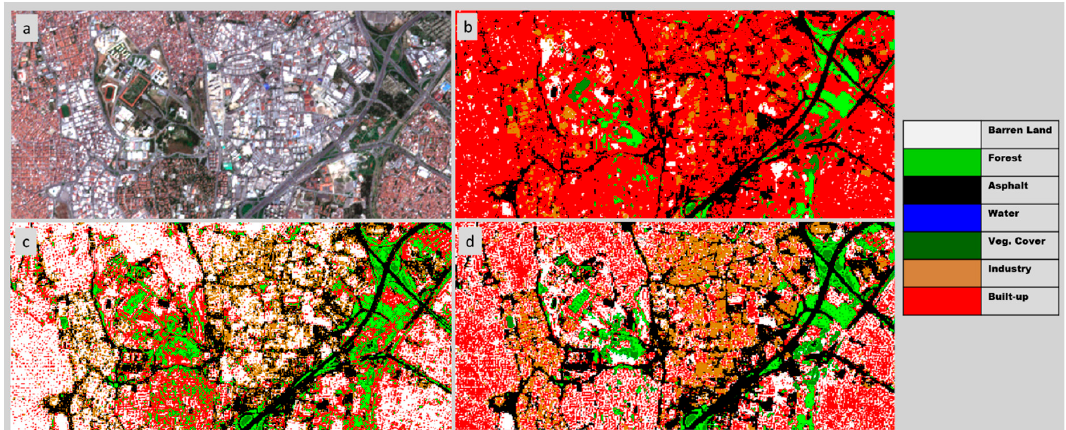
Figure 9. ( a ) RGB image of the Sentinel-2A; ( b ) the classified Sentinel-2A; ( c ) the classified multi-index (NDBI, NDVIre, and MNDWI), and ( d ) the classified multi-index (NDTI, NDVIre, and MNDWI) images.